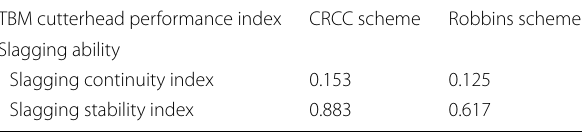
Table 2 Evaluation of cutterhead slagging